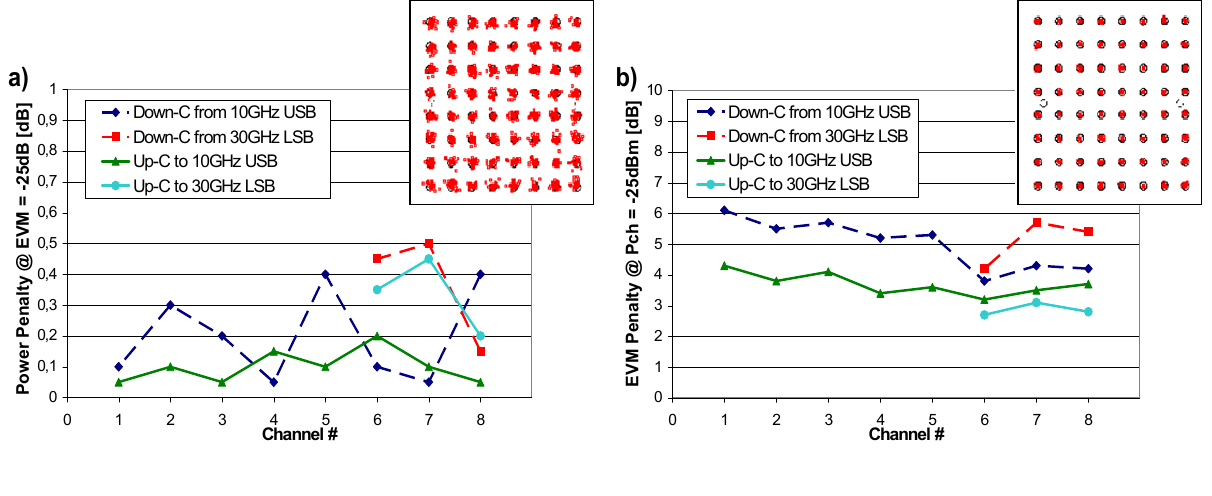
Figure 5. ( a ) Power penalty in up- and down-conversion for every up- or down-converted channel (Up/Down-C) to or from different frequencies. Inset: detected constellation for a received EVM of − 25 dB; ( b ) EVM penalty measurements for a received power of − 25 dBm, in up- and down-conversion for every channel up- or down-converted to or from different frequencies. Inset: detected constellation for a received power of − 25 dBm. The channels are numbered in order of increasing